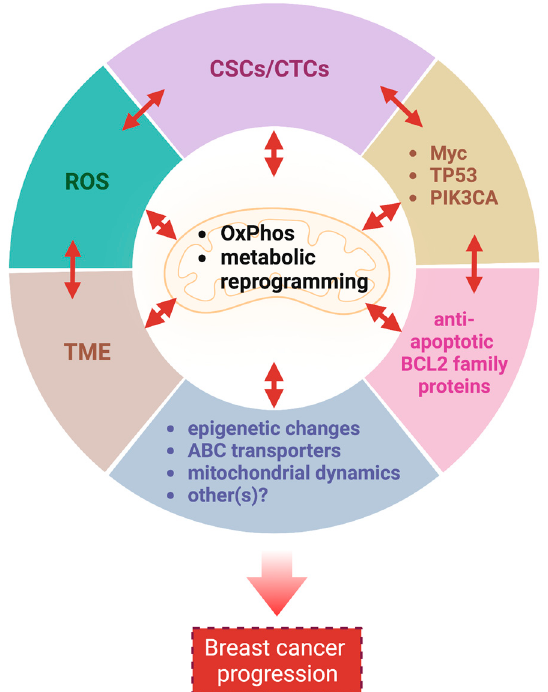
Figure 2. Mitochondria are critical for breast cancer progression. Mitochondria support breast cancer progression via multiple interrelated mechanisms. CSCs: cancer stem cells; CTCs: circulating tumor cells; ROS: reactive oxygen species; TME: tumor microenvironment; PIK3CA: phosphatidylinositol-4,5-bisphosphate 3-kinase catalytic subunit alpha; ABC: ATP-binding cassette. This figure was generated by BioRender.com (19 January 2023).